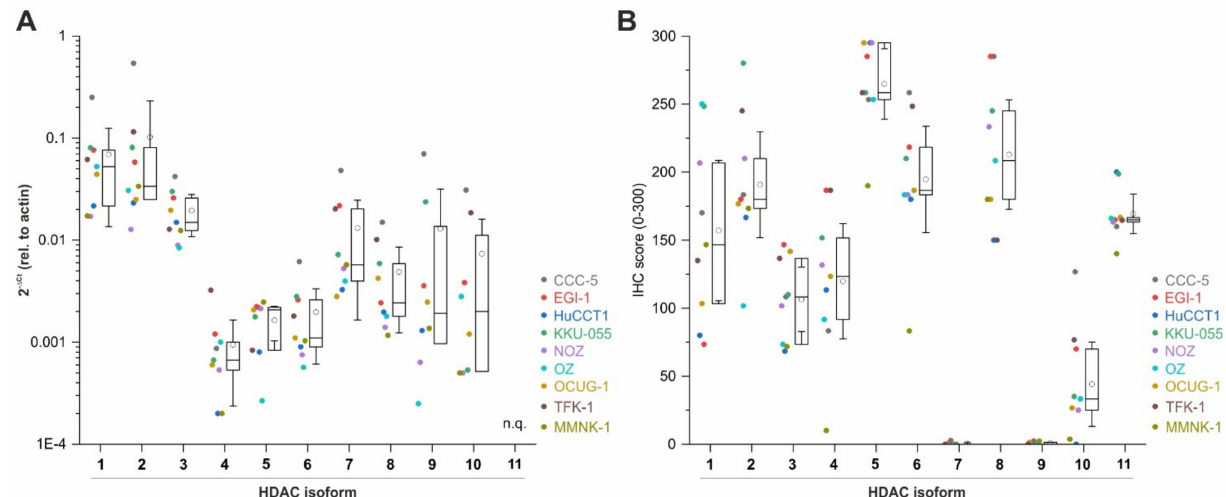
Figure 1. Expression analysis of HDACs in BTC cell lines. ( A ) mRNA levels of HDACs 1–11 in n = 8 BTC cell lines and non-tumor cholangiocytes MMNK-1 (HDAC 11 not quantifiable (n.q.) on mRNA level). ( B ) Protein expression of HDACs 1–11 in BTC and non-tumor cholangiocytes MMNK-1 cell blocks by immunohistochemistry (IHC). Data are presented as mean value of n = 3 biological replicates. Box plots indicate the 25/75 percentiles; whiskers stand for 95% confidence intervals. Abbreviations: BTC, biliary tract cancer.